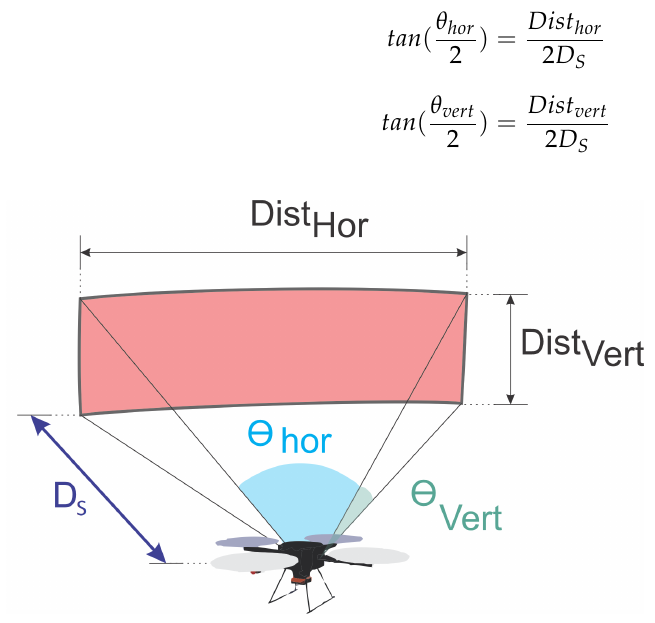
Figure 3. Problem